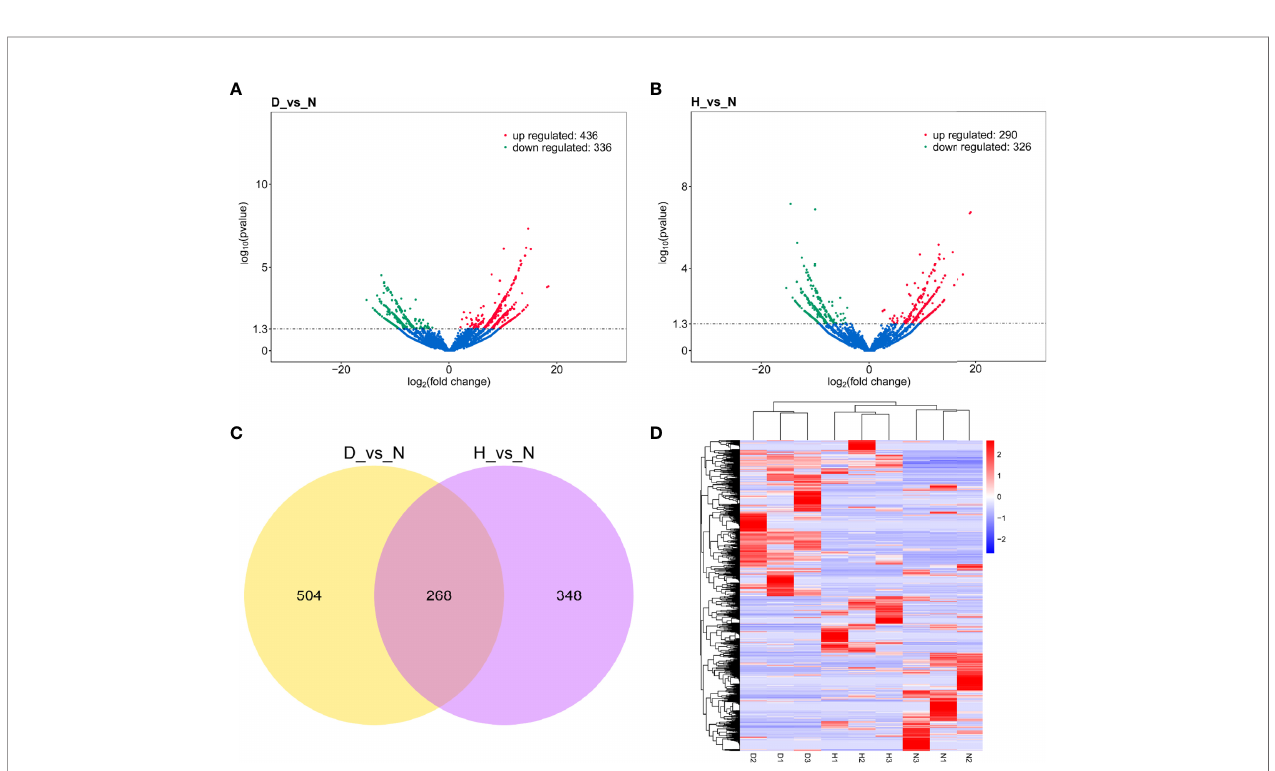
FIGURE 4 | (A) Volcano plot of DELs in D-vs-N comparison. (B) Volcano plot of DELs in H-vs-N comparison. The vertical line represents a 1.3-fold induction threshold, and the horizontal line represents a cutoff for signi fi cance P < 0.05. Red points indicated up-regulated transcripts, and green points indicated down- regulated transcripts. (C) Venn diagrams depicting the numbers of DELs in D-vs-N comparison and H-vs-N comparison. (D) There is hierarchical clustering of DELs in the nine samples (red represents a high expression, and blue represents a low